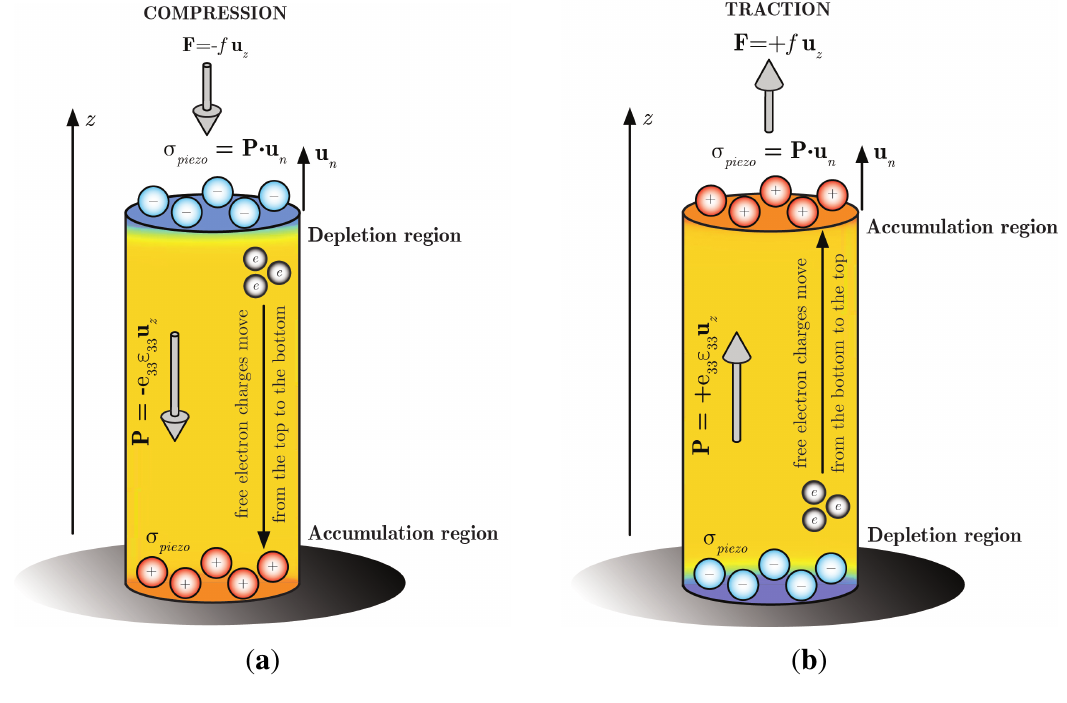
Figure 8. Schematic of the NW under compressive (a) and tensile strain